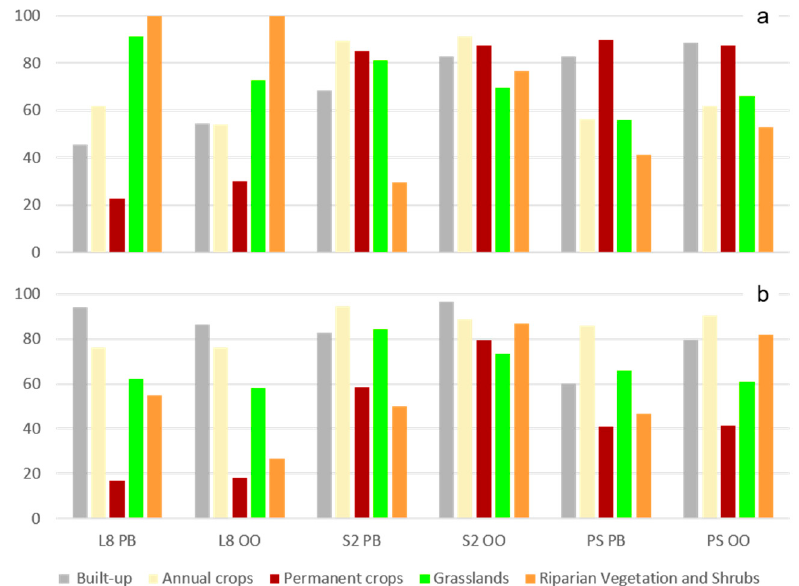
Figure 6. Comparison of producer’s ( a ) and user’s ( b ) accuracies of the LULC classes from the selected classifications (L8: Landsat 8, S2: Sentinel 2; PS: PlanetScope; PB: pixel-based; OO: object-oriented). Woodlands and water LULC classes are omitted.